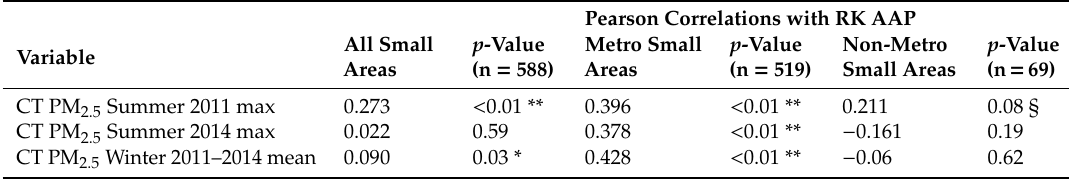
Table 4. Correlations Between RK AAP and CT PM 2.5 data for metro and non-metro small areas.